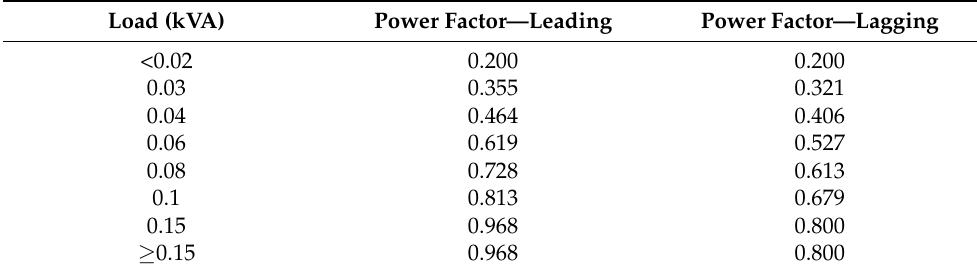
Table 8. ATU total harmonic distortion and power factor